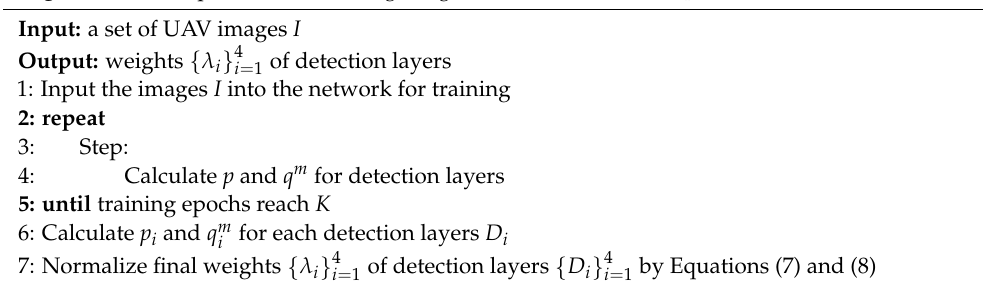
Algorithm 2. The procedure of setting weights for confidence loss e